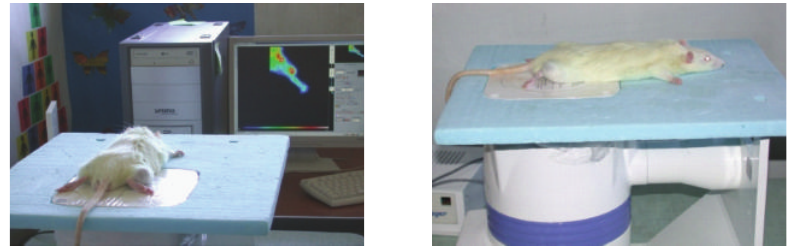
Figure 2: In vivo scintigraphic acquisition of chondrosarcoma bearing rats using a small animal dedicated gamma camera.